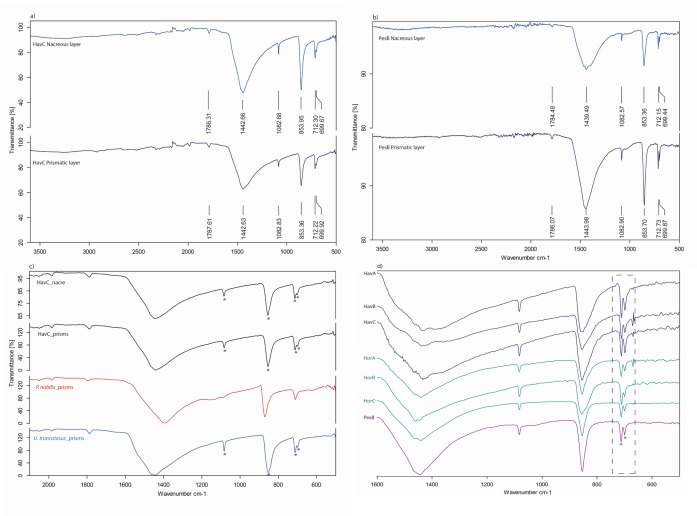
FTIR-ATR spectra of the double-buttons.Asterisks mark aragonite marker absorption bands. Nacreous and prismatic layers of (a) HavC, (b) PesB; (c) FTIR-ATR spectra comparison between HavC nacre and prismatic layers (black) with calcitic prismatic layer of Pinna nobilis (red) and aragonitic Unio truncatosus (blue), confirming the fully aragonitic mineralogy of both layers; (d) FTIR-ATR spectra of all the double-buttons, sampled in ‘bulk’: the presence of doublets (CO in-plane bending mode) at ~ 712 and~700 cm−1 (dashed line) in all samples indicates absence of recrystallization of the biogenic carbonate.